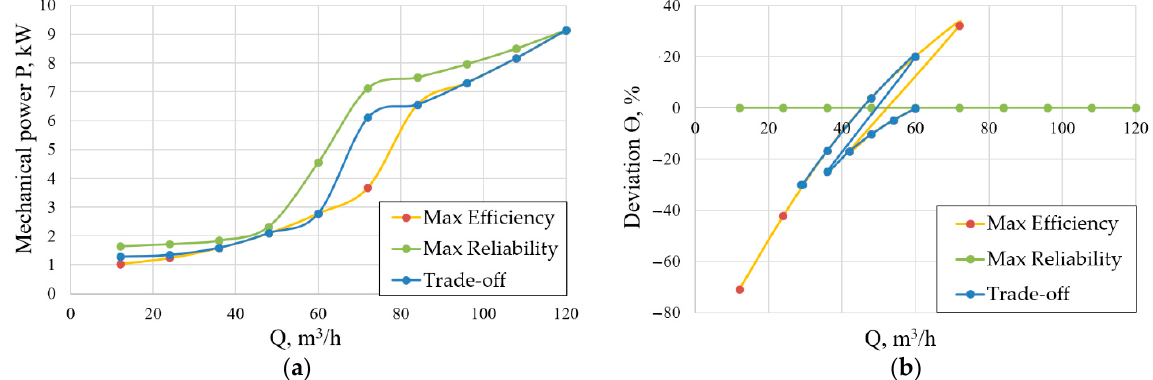
Figure 6. Comparison of pump performances under the different control methods: ( a ) total mechanical power of the pump system; ( b ) deviation between the current operating point and the BEP.